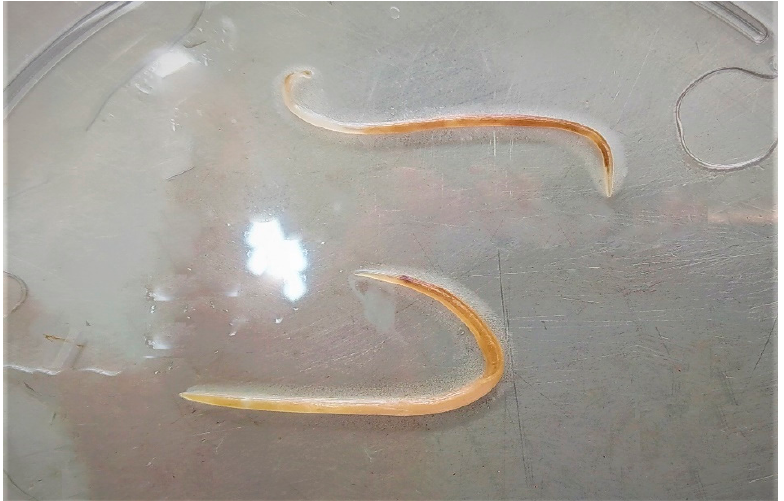
Figure 1. The two parasitic nematodes (at the bottom Individual 1 and at the upper Individual 2) that were obtained from the stomach contents of the Mediterranean monk seal. (credits: Laboratory of Ichthyology and Hydrobiology, Dept. of Ichthyology and Aquatic Environment, University of Thessaly).